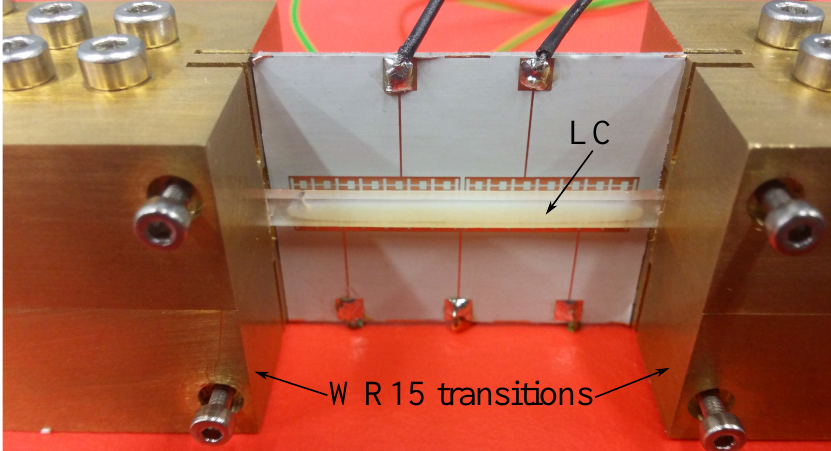
Figure 21. Photograph of the partially assembled PPDW phase